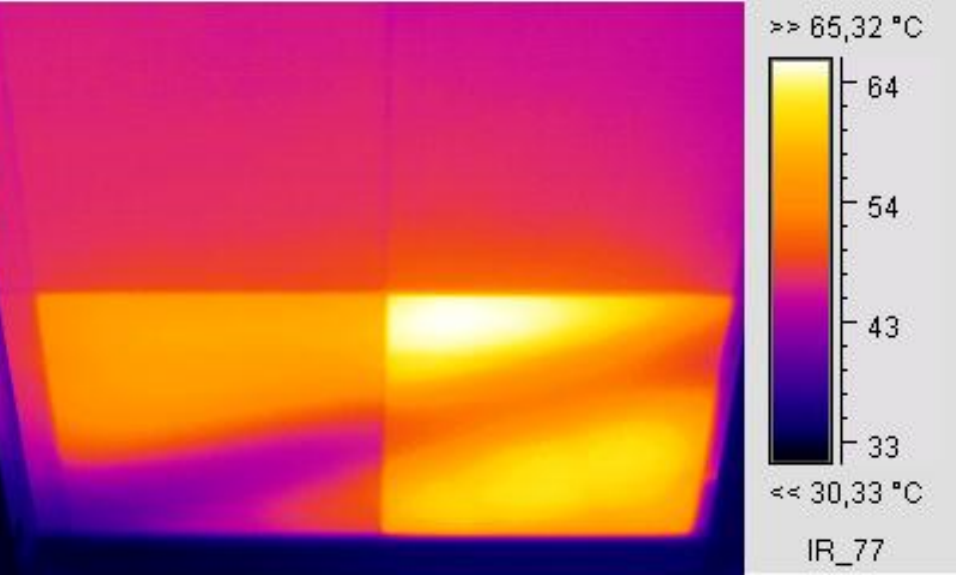
Figure 1. IR thermography of a pc-Si module captured at the backside of the module, showing a transient shadow falling diagonally on the two bottom cells, creating temporary T c patterns in the affected cells.